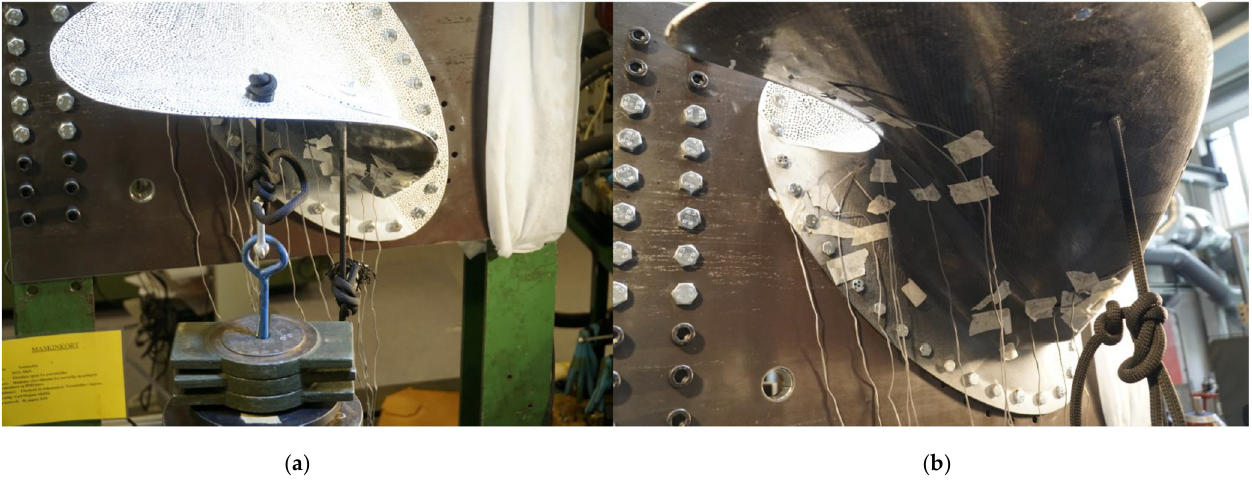
Figure 9. ( a ) The load was applied by hanging metal weights. The CFRP propeller blade is loaded with 500 kg, 375 kg at the 0.7 radius line and 125 kg at the 0.9 radius point in the left photo. ( b ) The strain gauges were attached on the blade and the root.